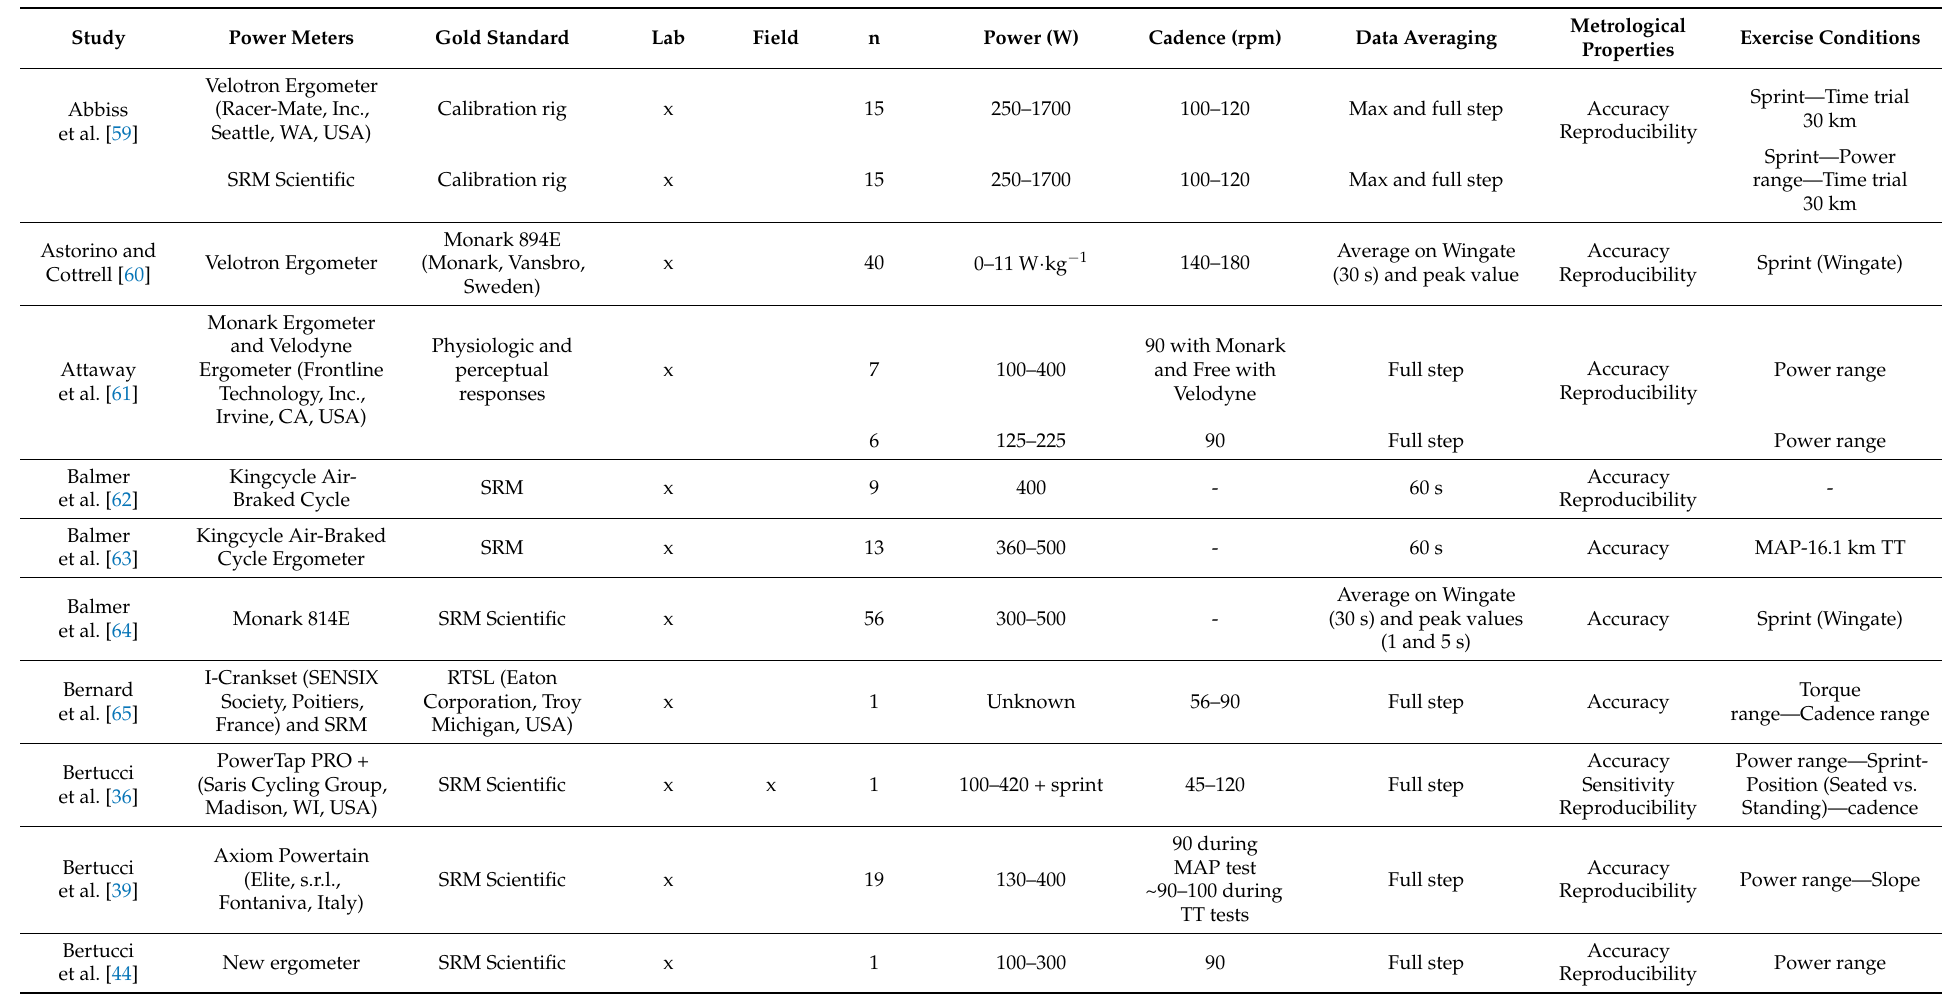
Table 1. Overview of the studies included in this